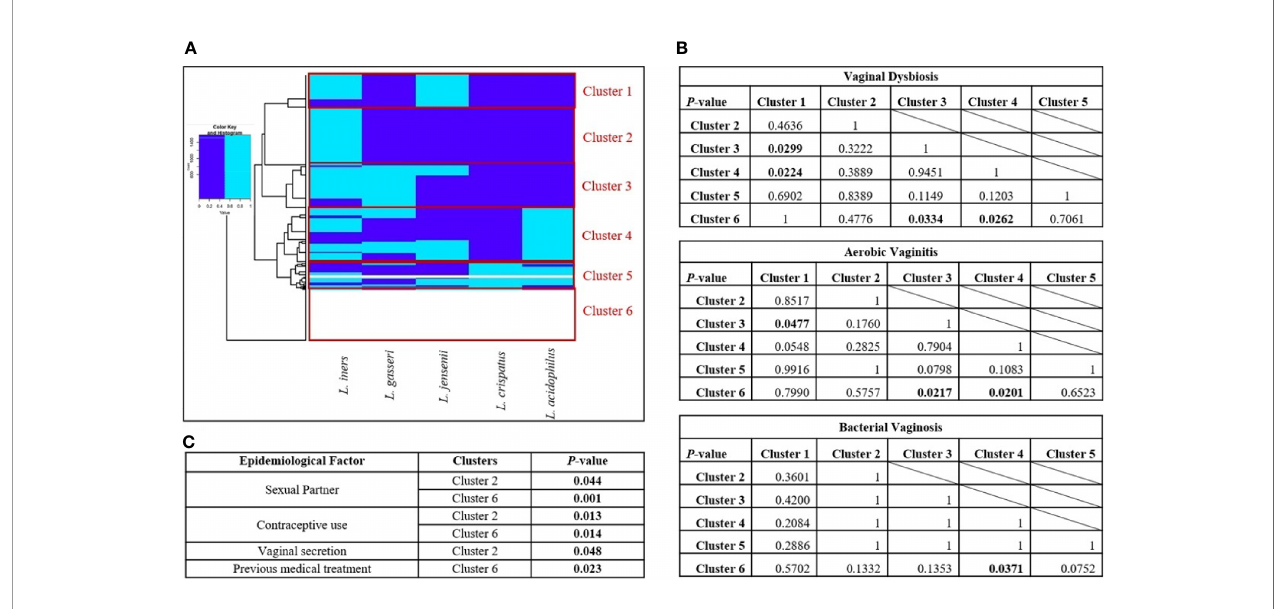
FIGURE 3 | Clustering of the vaginal samples according to the prevalence of Lactobacillus sp. (A) Clusters obtained by Ward ’ s Minimum Variance Clustering Method. (B) Chi-square analysis between clusters in presence of vaginal dysbiosis, aerobic vaginitis, and bacterial vaginosis. (C) Epidemiological factors related to each cluster. Six clusters were chosen according to the presence of different Lactobacillus species in vaginal samples using Ward ’ s Minimum Variance Clustering Method. The following clusters are in panel (A) , Cluster 1 was characterized by the presence of Lactobacillus iners and Lactobacillus jensenii ; Cluster 2 only showed L. iners ; Cluster 3 was constituted by L. iners , L. jensenii , and Lactobacillus gasseri ; Cluster 4 was formed by L. iners , L. jensenii , L. gasseri , and Lactobacillus acidophilus ; Cluster 5 is a mixture of all Lactobacillus species; and Cluster 6 shows the absence of all of them. The dark blue color indicates the absence of a Lactobacillus species; meanwhile, the light blue color indicates the presence of the Lactobacillus species. In panel (B) , chi-square tests were performed to assess the statistical differences between clusters. The p -values where statistically signi fi cant differences were found are shown in bold. Finally, in panel (C) , multiple chi- square tests were performed to evaluate the epidemiological factors related to the presence of each cluster; the signi fi cant values are featured in the corresponding table in